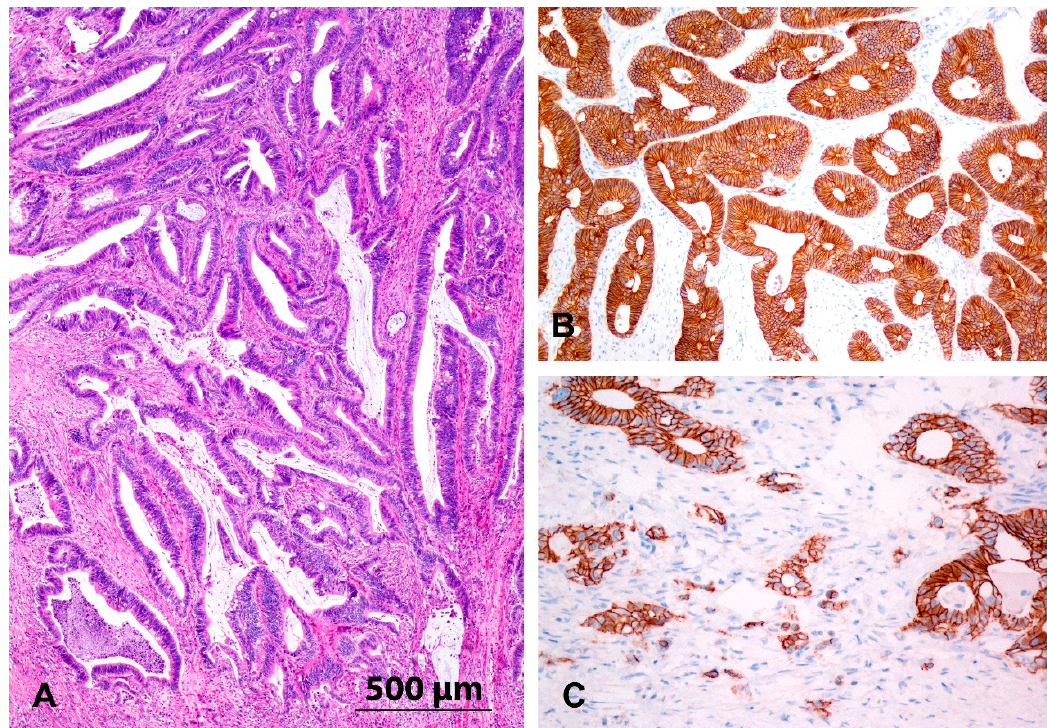
Figure 2. ( A ) Moderately differentiated adenocarcinoma. HE, orig. magnification 40×; ( B , C ) Immunohistochemistry for E-cadherin in adenocarcinoma ( n = 30): strong membranous reaction in central part of the tumour ( B ) and focally reduced staining at the invasive tumour front ( C ). Orig. magnification 100×.